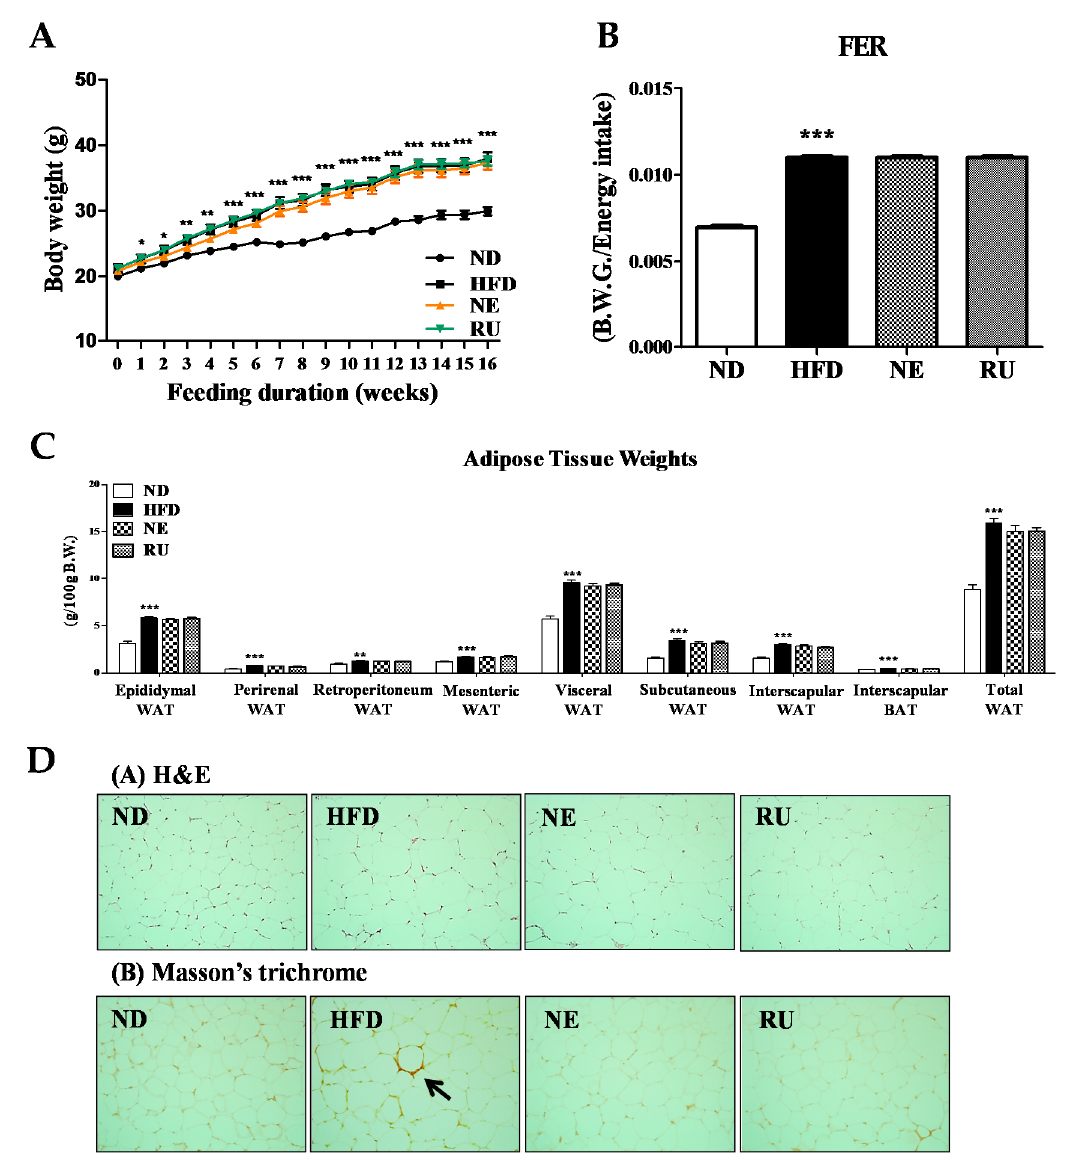
Figure 1. Effect of NE and RU supplementation for 16 weeks on body weight ( A ), food efficiency ratio (FER) ( B ), adipose tissue weights ( C ) and epididymal white adipose tissue morphology (200× magnification) ( D ) in C57BL/6J mice fed high-fat diet. Data are mean ± S.E. Significant differences between HFD versus ND are indicated; * p < 0.05, ** p < 0.01, *** p < 0.001. The food efficiency ratio is given as the body weight gain per energy intake per day.